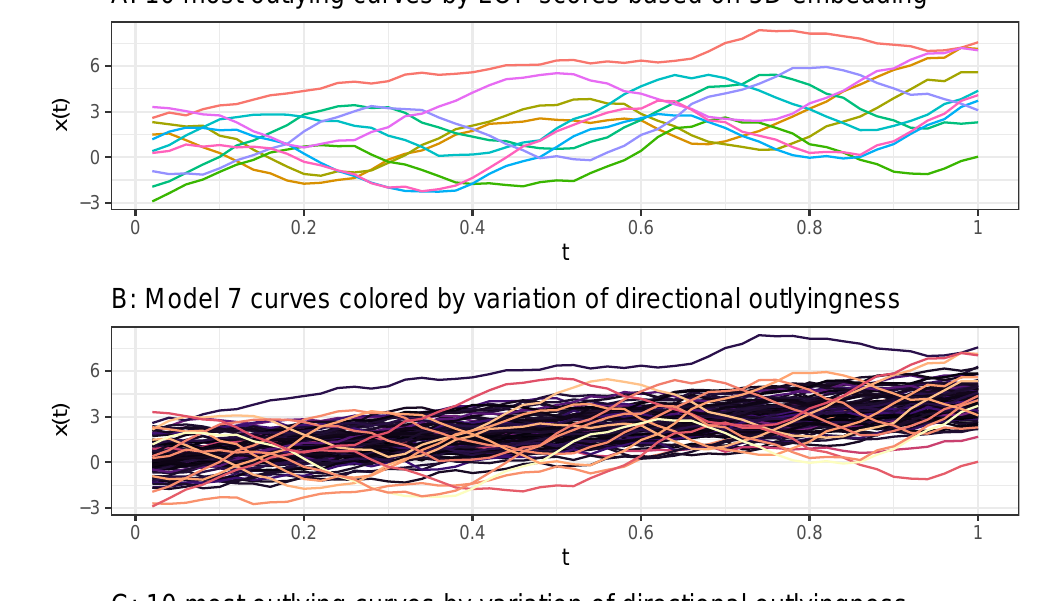
C: 10 most outlying curves by variation of directional outlyingness